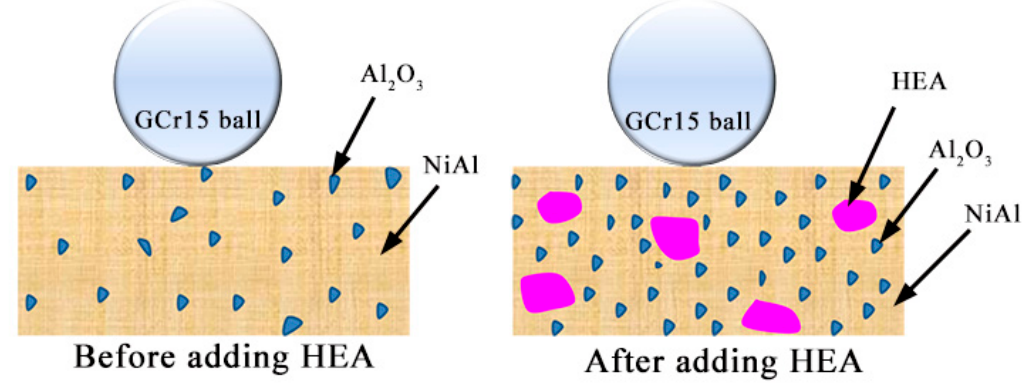
Figure 13. Schematic diagram of Al 2 O 3 particle content of composites before and after the HEA addition.